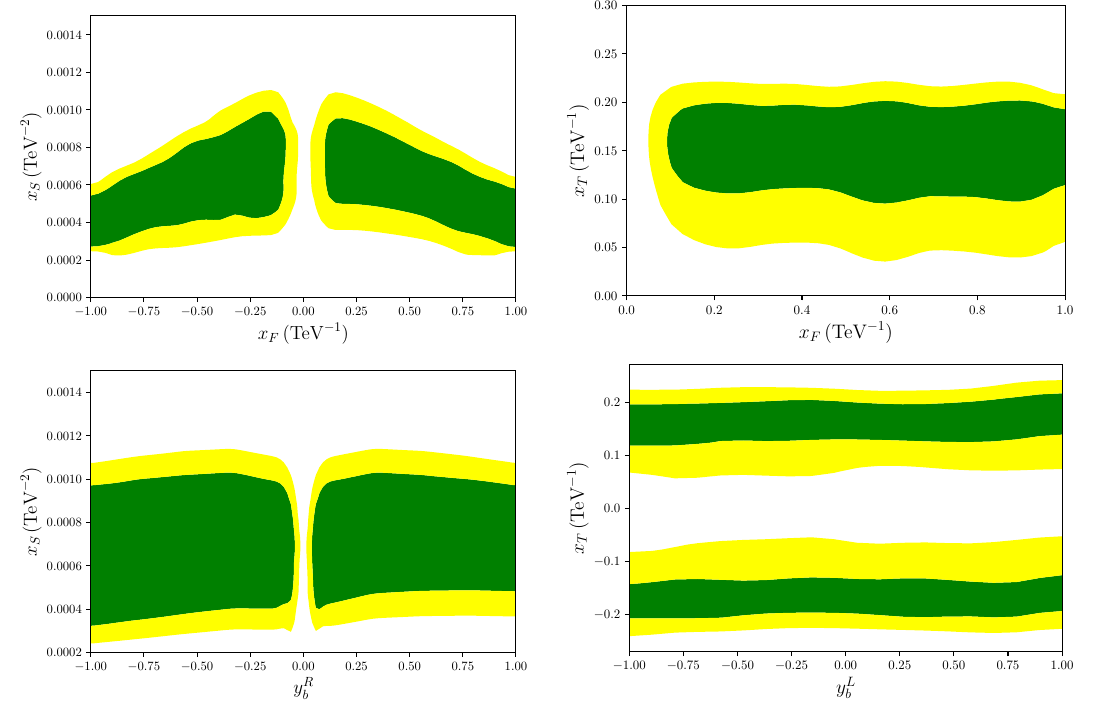
Figure 5 . The 1 (2)- σ regions in green (yellow) around the model’s best fit point. For every plot, the vertical axis represents a coupling that enters observables a tree-level, whereas the horizontal axis represents one that only contributes at one-loop. For each point in the plot, the other couplings were marginalized in order to minimize the χ 2 . The observables included in the fit were the ones available in smelli in the classes EWPO, leptonic observables, lepton flavour universality for neutral currents and quark flavour observables, and (cid:15) µµ